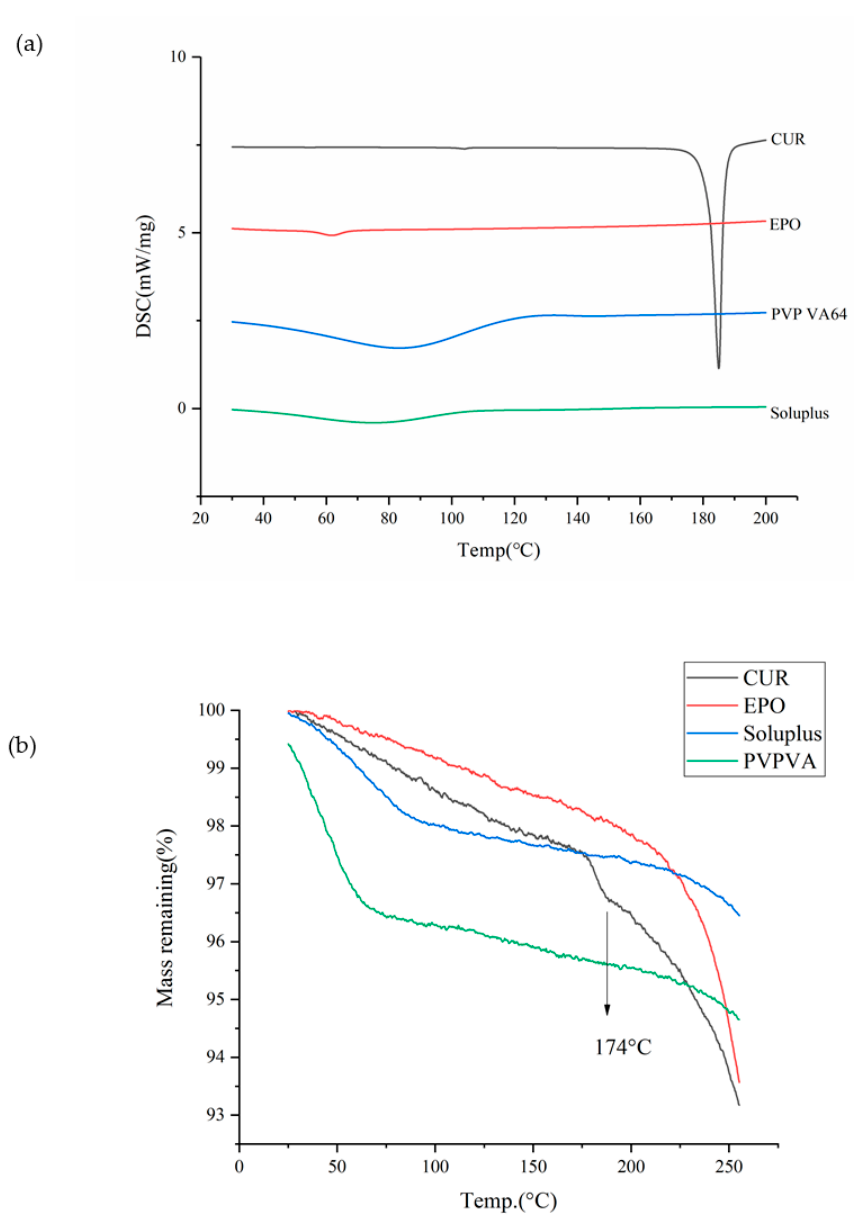
Figure 1. The DSC ( a ) and TGA ( b ) curves of samples.